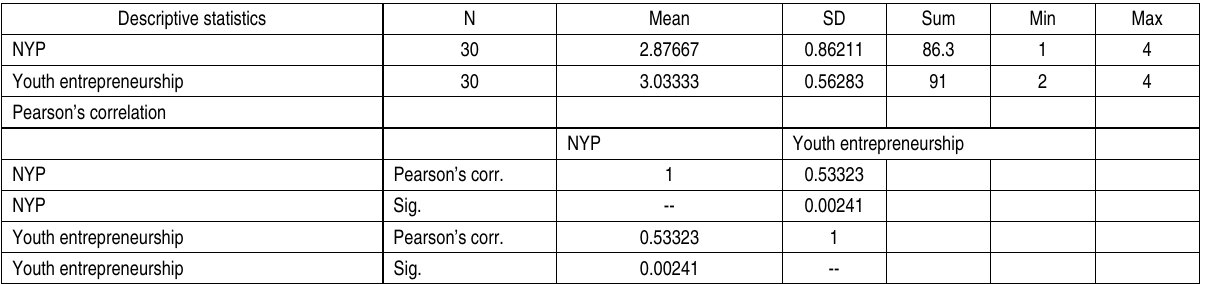
Table 1. Correlation between youth entrepreneurship development and National Youth Policy (NYP) Descriptive